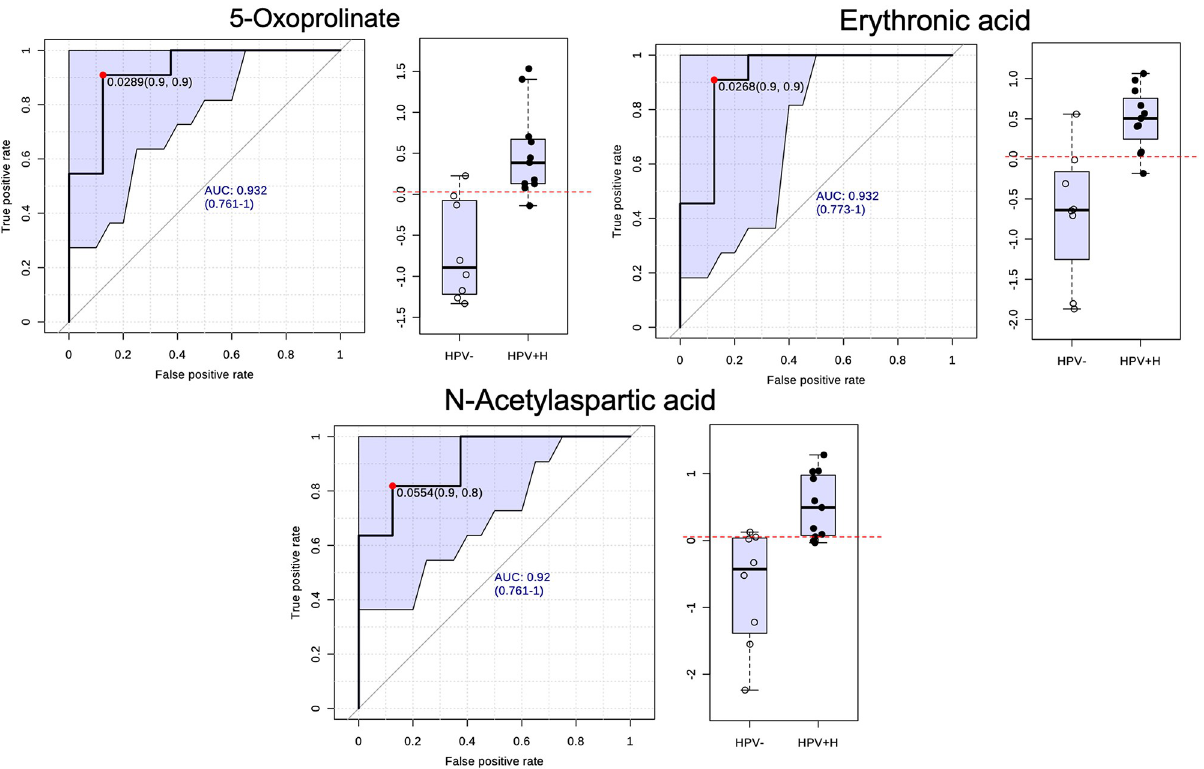
Fig 2. Urine biomarkers predicted by ROC curve analysis curve with 95% confidence interval (shadowed). Box-and-whisker plots show the distribution of abundance values of 5-Oxoprolinate, Erythronic acid and N-Acetylaspartic acid in HPV- vs HPV+H samples with the optimal cut-off as a horizontal dotted red